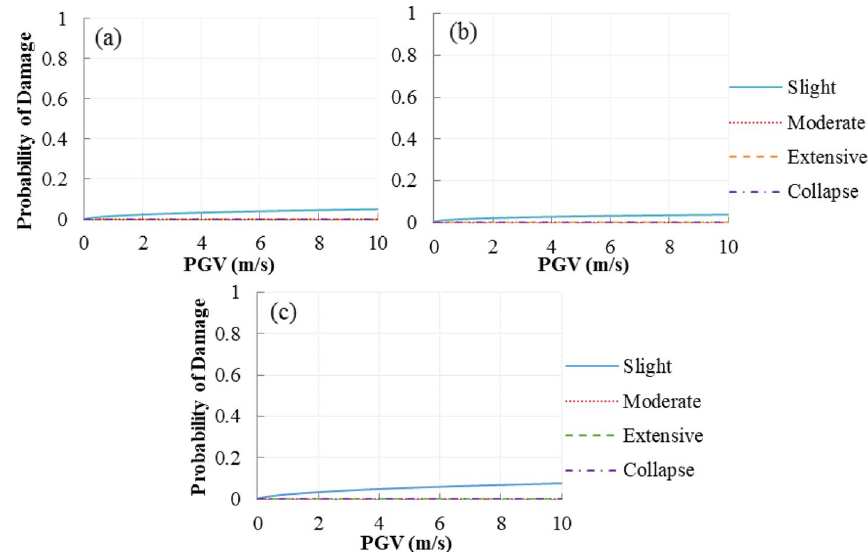
Fig. 14 Fragility curves of cable ( a ) Floating System, ( b ) Rigid System, and ( c )